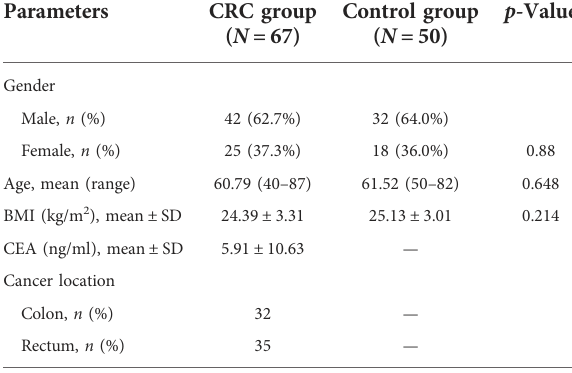
TABLE 1 Clinical characteristics of the study